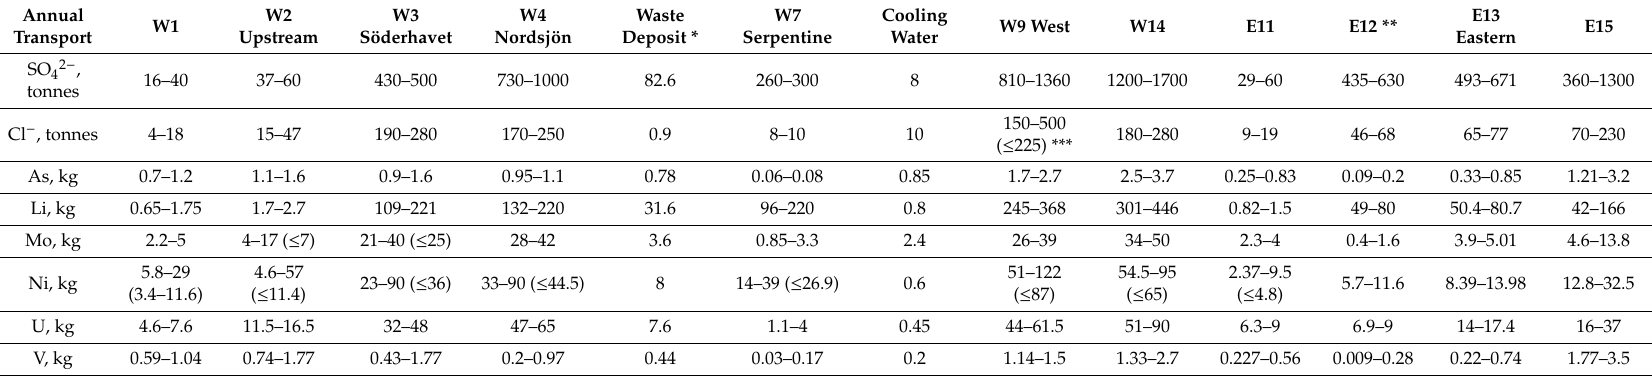
Table 6. Annual mass transport, 2016-2019. The span includes di ff erences between the years and results from the di ff erent flow estimate methods (locality W1, W2, W9, W14, E11, E15) used in